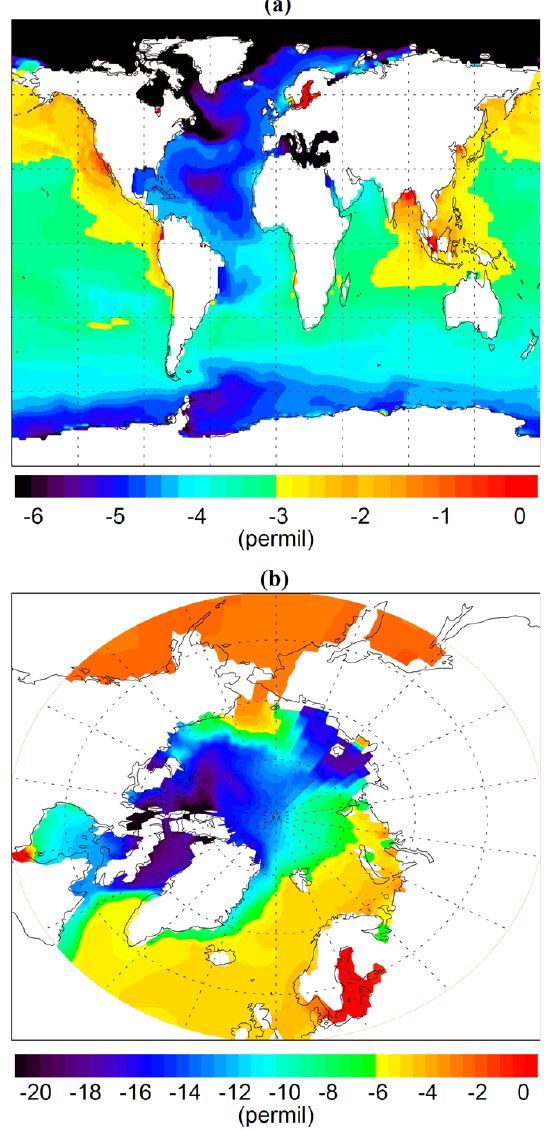
Fig. 10. (a) Annual mean d -excess distribution at sea surface as simulated by MPI-OM. (b) The same as (a) , but for the region north of 53 ◦